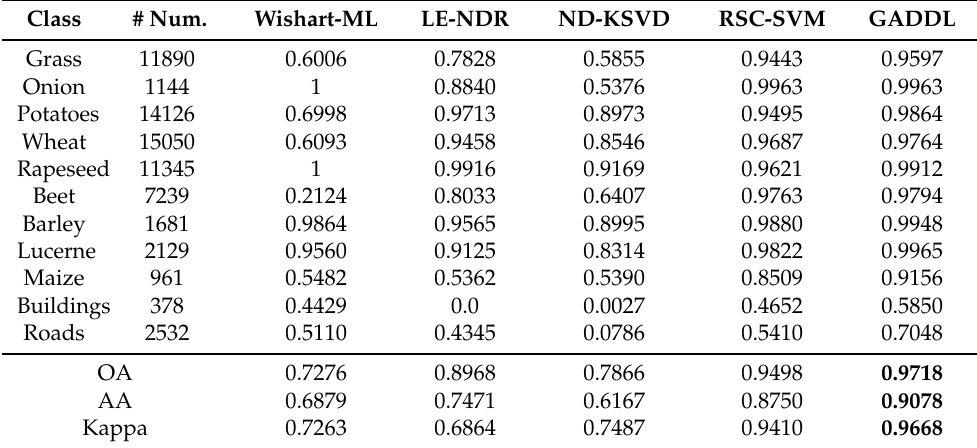
Table 3. The overall accuracy (OA), average accuracy (AA) and kappa coefficient values of different methods on Flevoland-1991 dataset. # Num. denotes the number of samples of each category.